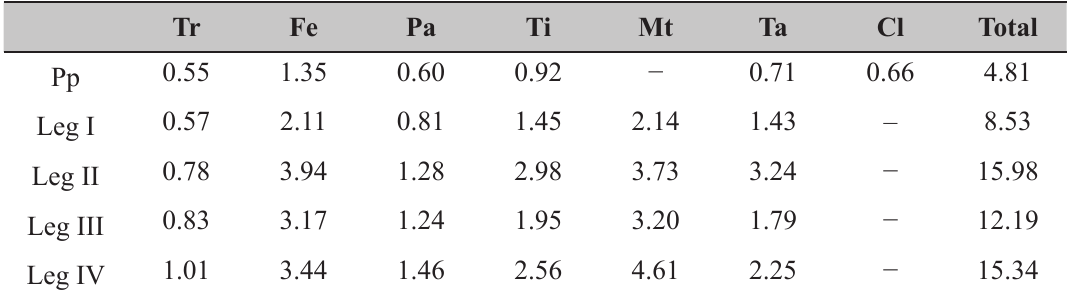
Table 5. Leg measurements of Lacronia nigra (B. Soares, 1942) comb. nov., ♂ (MNRJ 60385). Tr Fe